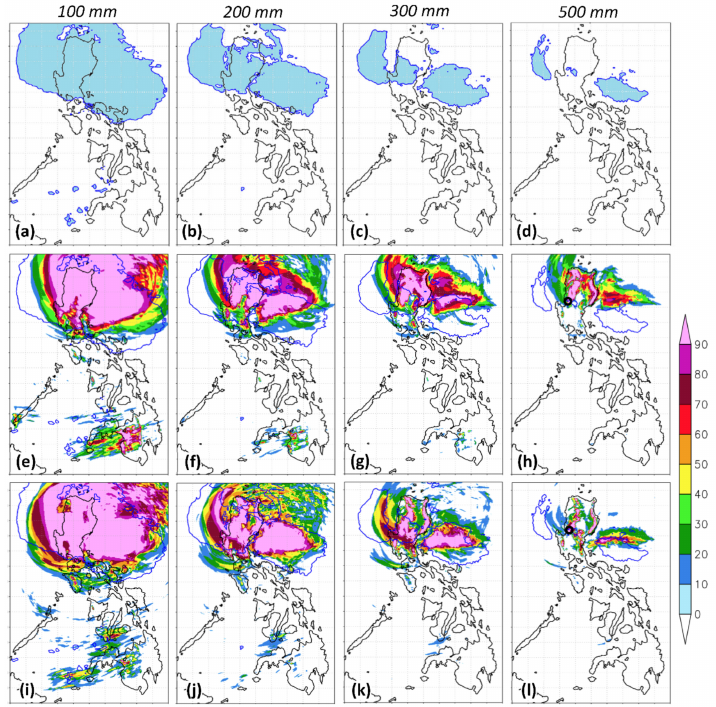
Figure 11. As in Figure 6, except for ( a – d ) areas reaching the specified thresholds, respectively, for the 72 h period from 1200 UTC on 16 to 1200 UTC on 19 October from TY Koppu (2015) and probabilities (%) of 72 h QPFs for the same period to reach those thresholds from ( e – h ) the first eight time-lagged members (with t 0 during 13–14 October) and ( i – l ) the last seven members (with t 0 during 15–16 October). The location of Baguio is marked with an open circle in ( h , l